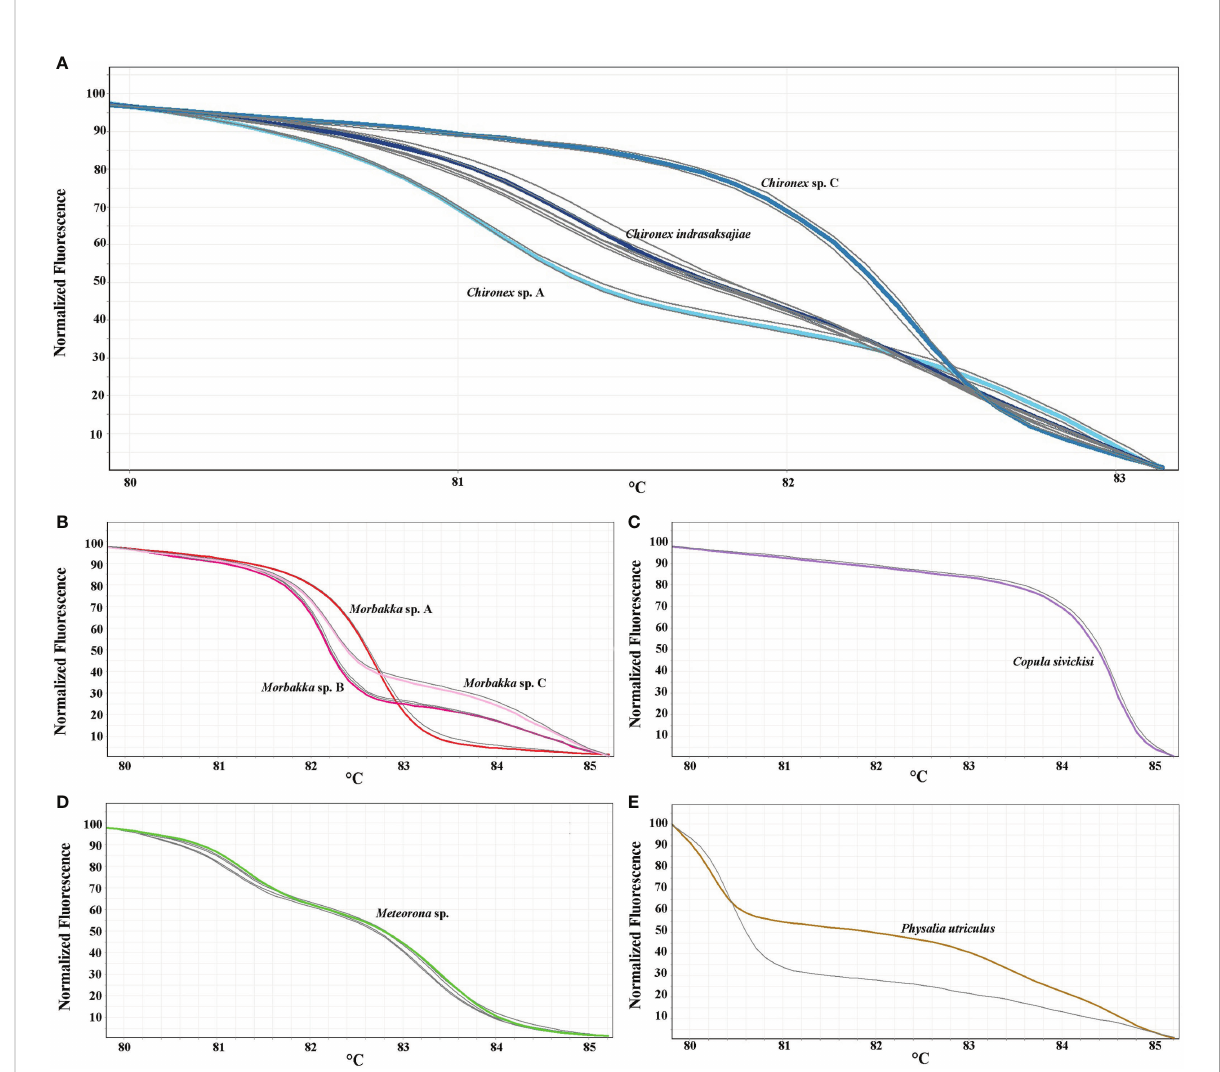
FIGURE 4 HRM pro fi les of 22 analyzed jelly fi sh samples (gray color) with the 16S rRNA primers. HRM curves showing in normalized melting plot. (A) Chironex samples (n=12), (B) Copula sample (n=1), (C) Meteorona samples (n=4), (D) Morbakka samples (n=4), (E) Physalia sample